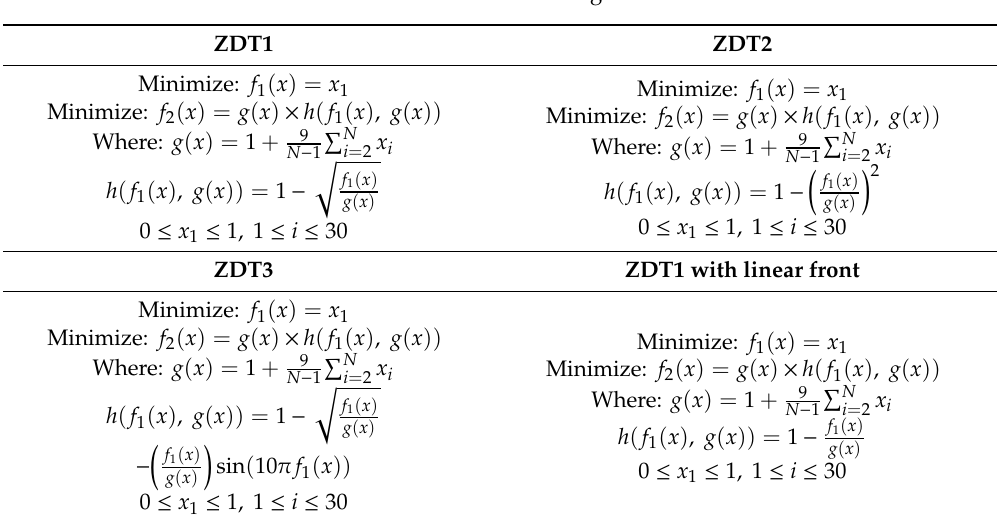
Table 6. Test functions of